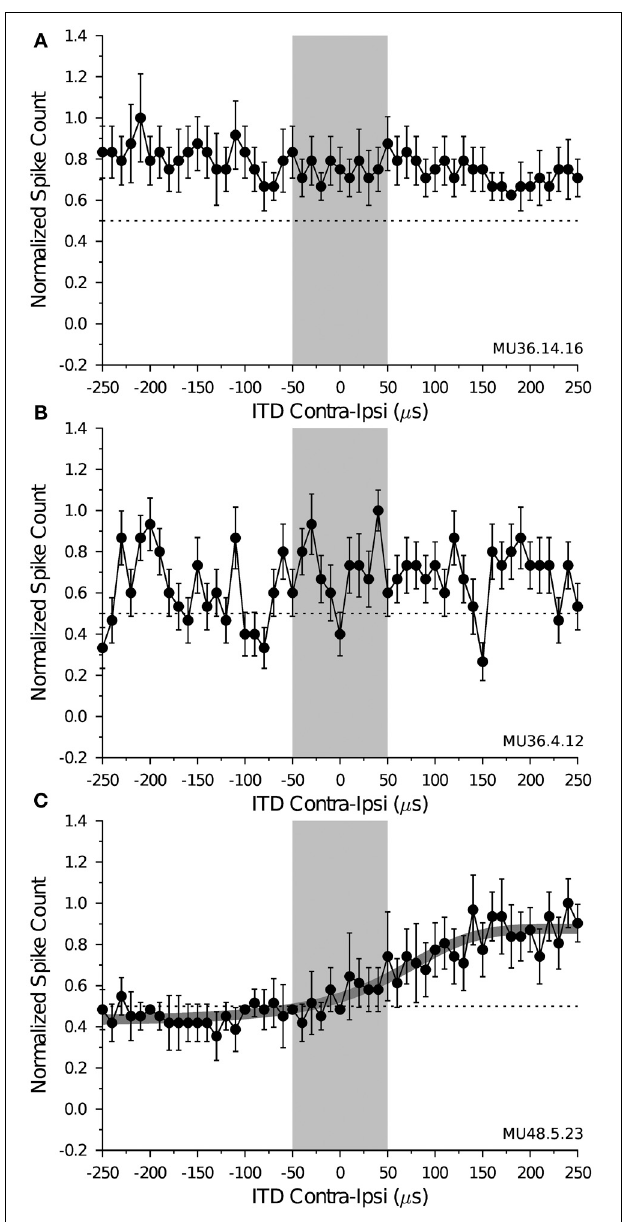
FIGURE 4 | Example interaural time difference (ITD) response functions measured from IC neurons of the big brown bat. Each panel shows the mean ± SE spikes per stimulus, normalized to the response maximum and plotted as a function of the binaural ITD, measured as the contralateral stimulus onset time minus the ipsilateral stimulus onset time. The gray region spanning from ± 50 μ s represents the maximum range of ITD cues for an adult Eptesicus fuscus and the horizontal dotted line represents 50% of the maximum spike count. During data collection, the SPL of the presented signal was equal in both ears while the onset time of the ipsilateral stimulus was randomly varied in 10 μ s steps from − 250 to 250 μ s (re contra stimulus). The abscissa is the binaural ITD measured as the onset time of the contralateral stimulus minus the onset time of the ipsilateral stimulus, with negative values indicating the ipsilateral signal led the contralateral signal and positive values indicating the contralateral signal led the ipsilateral signal. (A) Non-selective ITD response function. Spiking